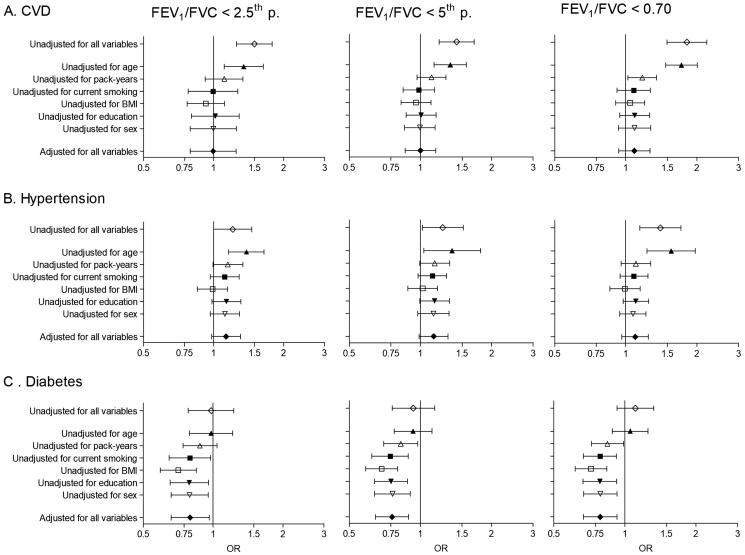
Meta-analyses of the odds ratios for comorbidities in subjects with airflow obstruction, showing the influence of the threshold to define airflow obstruction and adjusting for covariates. Summary forest plots showing the unadjusted, partly adjusted, and completely adjusted odds ratios (meta-OR) and the 95% CI for A. diabetes, B. hypertension, and C. CVD in subjects with airflow obstruction compared to those without airflow obstruction (left column: FEV1/FVC < 2.5th percentile, middle column: FEV1/FVC < 5th percentile, right column: FEV1/FVC < 0.70). Adjusting for all variables at the same time (as shown bottom of each panel), leaving out one variable for each model (middle of each panel), and running one model without any adjusting variables (as shown in the upper part of each panel). The variables age, smoking (pack-years and current smoking status), BMI, education and sex were analyzed. Details of these meta-analyses are reported in Supplementary Table 4.